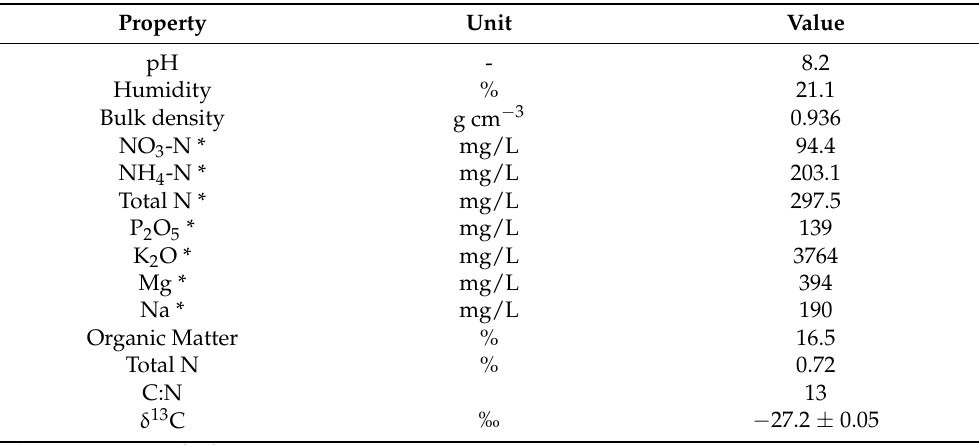
Table 2. Physicochemical characteristics of the compost used in the present work.